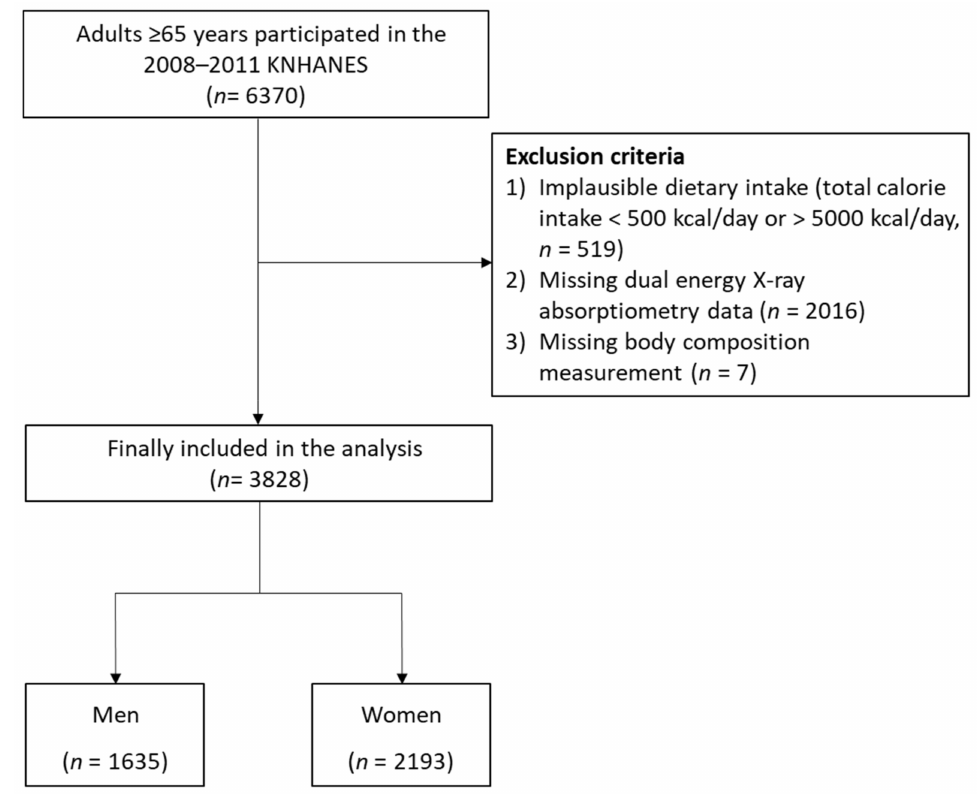
Figure 1. Flowchart of the study population